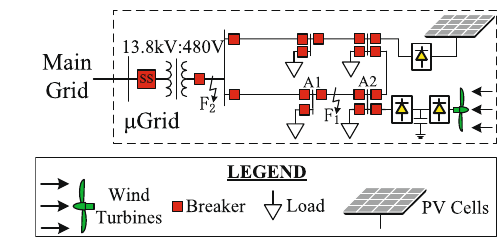
Fig. 1 Detail diagram of CIG control Fig. 2 Example system of μ Grid circuit